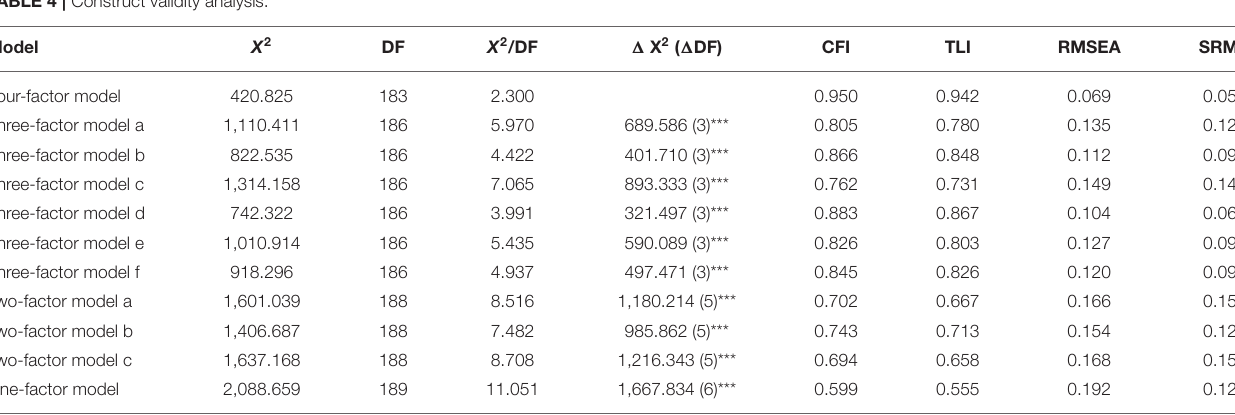
TABLE 4 | Construct validity